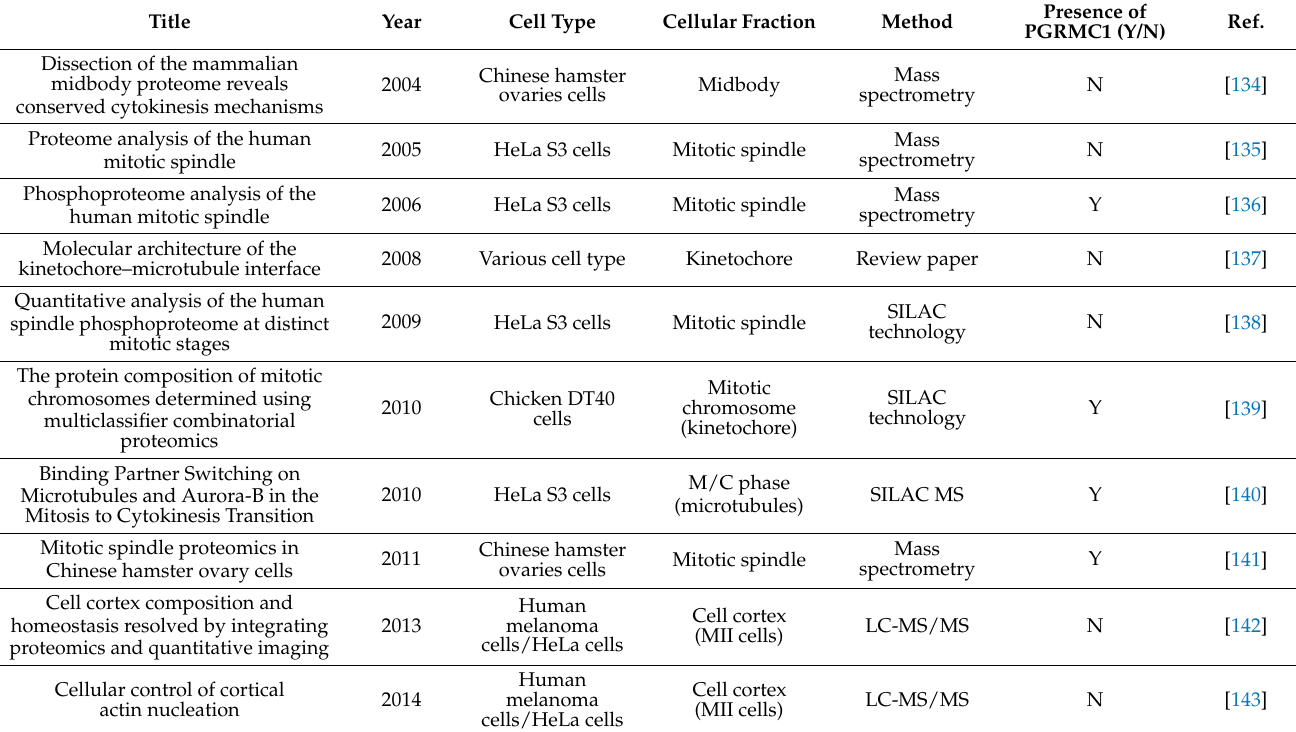
Table 2. Proteomic studies revealing (or not) PGRMC1 association with the spindle